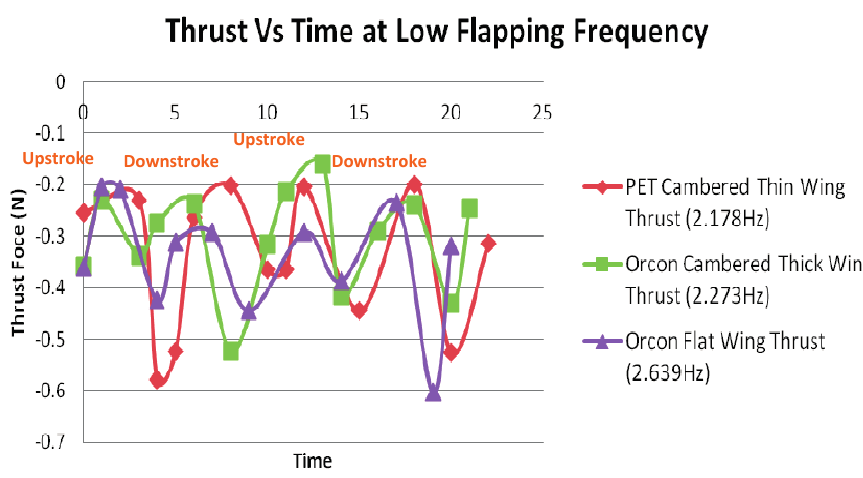
Figure 33. Thrust against low flapping frequency (2 full